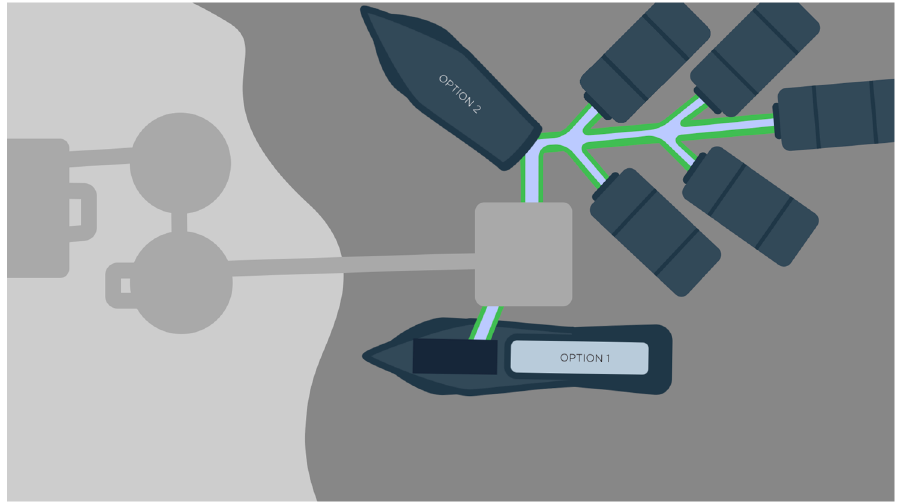
Figure 2. Notional concept of the proposed method for re-gasifying natural gas from natural gas hydrates produced from off-shore petroleum reserves. The facility would accommodate the appropriate shipping option.